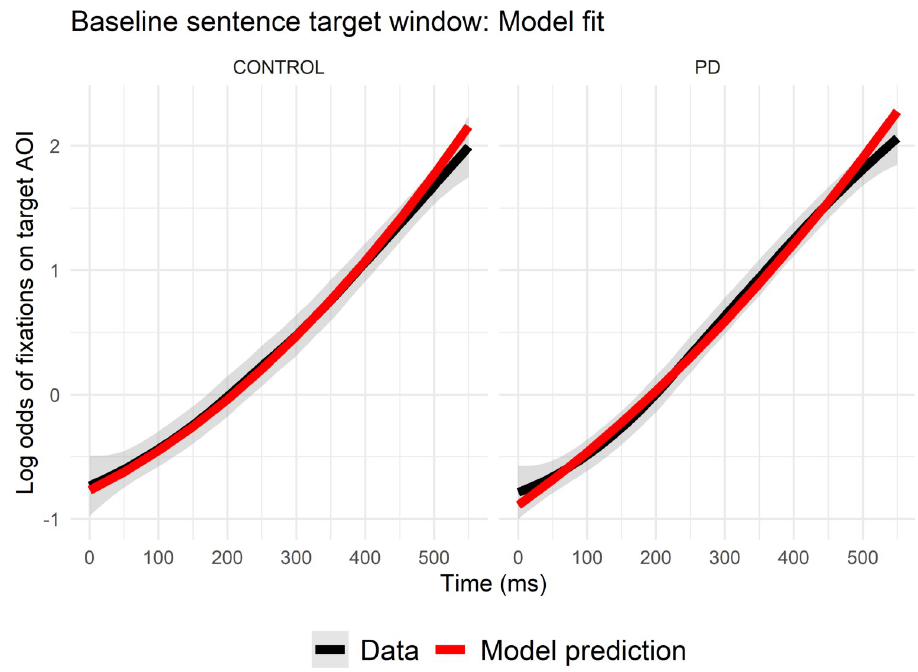
Fig 6. Target window model fit in baseline sentences. Actual vs. model-predicted log odds (logits) of fixations to the target interest area, averaged across subjects and trials over the duration of the target window for controls (left) and PD participants (right). The x-axis reflects the elapsed time in the target window in milliseconds, offset by 200ms to account for saccade programming/launching time.